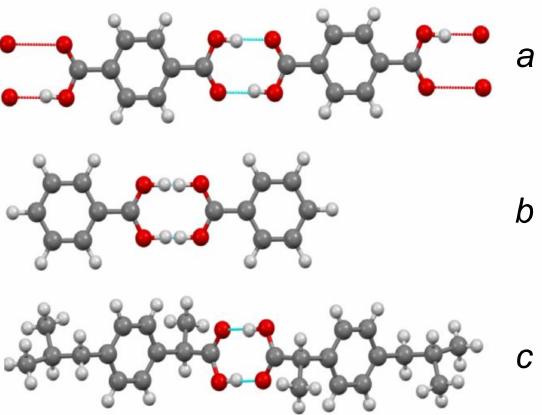
Figure 26. Chains of TPA molecules with symmetric- ( a ), BZ dimers with quasi-symmetric- ( b ), and IB dimers with asymmetric τ -bond ( c ). A slight deviation from symmetry in the benzoic acid dimer arises due to the crystalline effect, in which one of the four oxygen atoms of the τ -bond has a shorter contact with the environment than the other three. The asymmetry of dimer IB is due to two different carbon substituents adjacent to the α -carbon of the hydroxyl